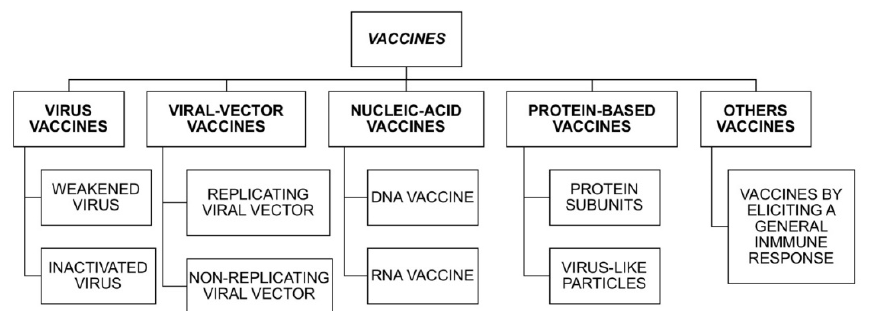
Figure 4. Severe acute respiratory syndrome coronavirus 2 (SARS-Cov-2) vaccine variety, adapted from Callaway (2020), pp. 576–577.